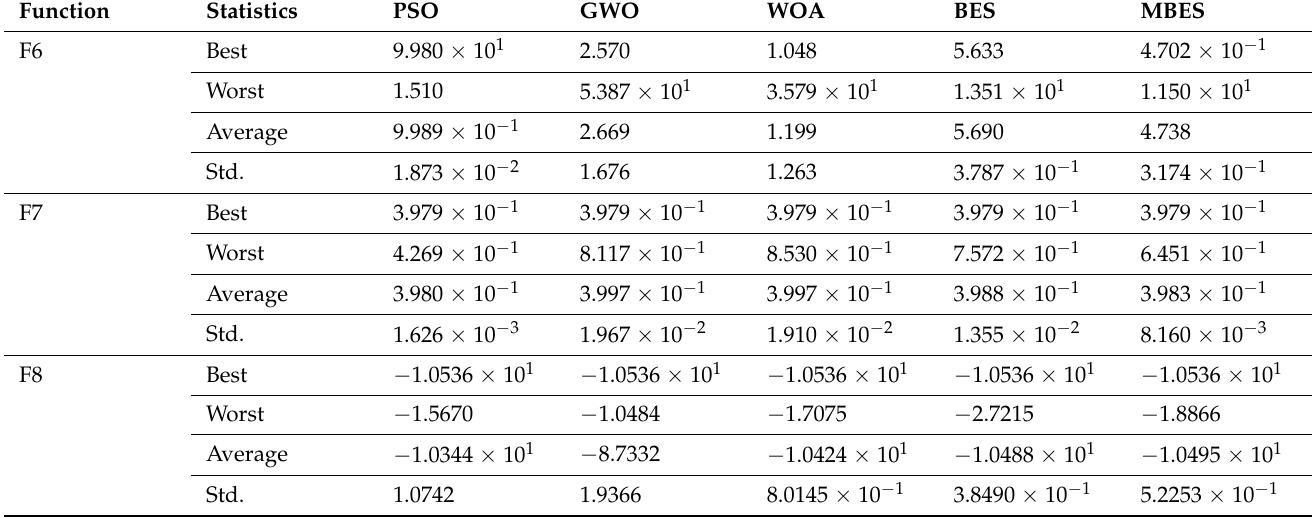
Table 5. Results for composite benchmark